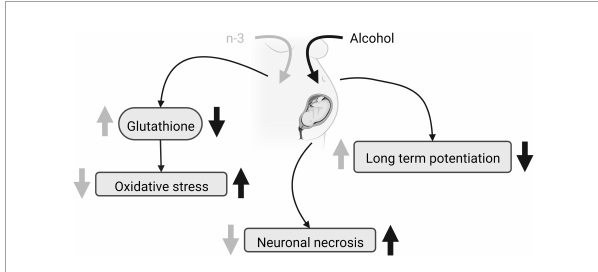
FIGURE1 FASD and n-3 effects. Due to maternal ethanol intake, fetal glutathione decreases, oxidative stress augments, neuronal necrosis raises and LTP is impaired. Maternal n-3 enriched diet increases glutathione, decreases oxidative stress, reduces neuronal necrosis and rescues LTP, mitigating ethanol harmful effects. Created with